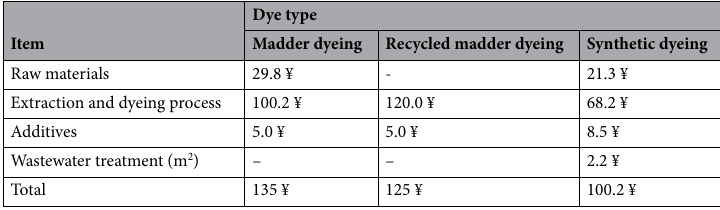
Table 7. Comparative cost of synthetic and plant dyeing for 1 kg